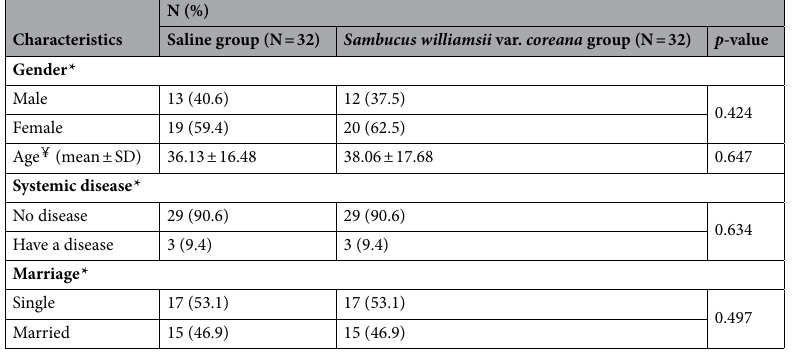
Table 1. Characteristics of the subjects in the saline group and Sambucus williamsii var . coreana group. ￥ p -values are determined by independent t-test, *p -values are determined by chi-square test, ( p < 0.05). Values are means ± standard deviations.